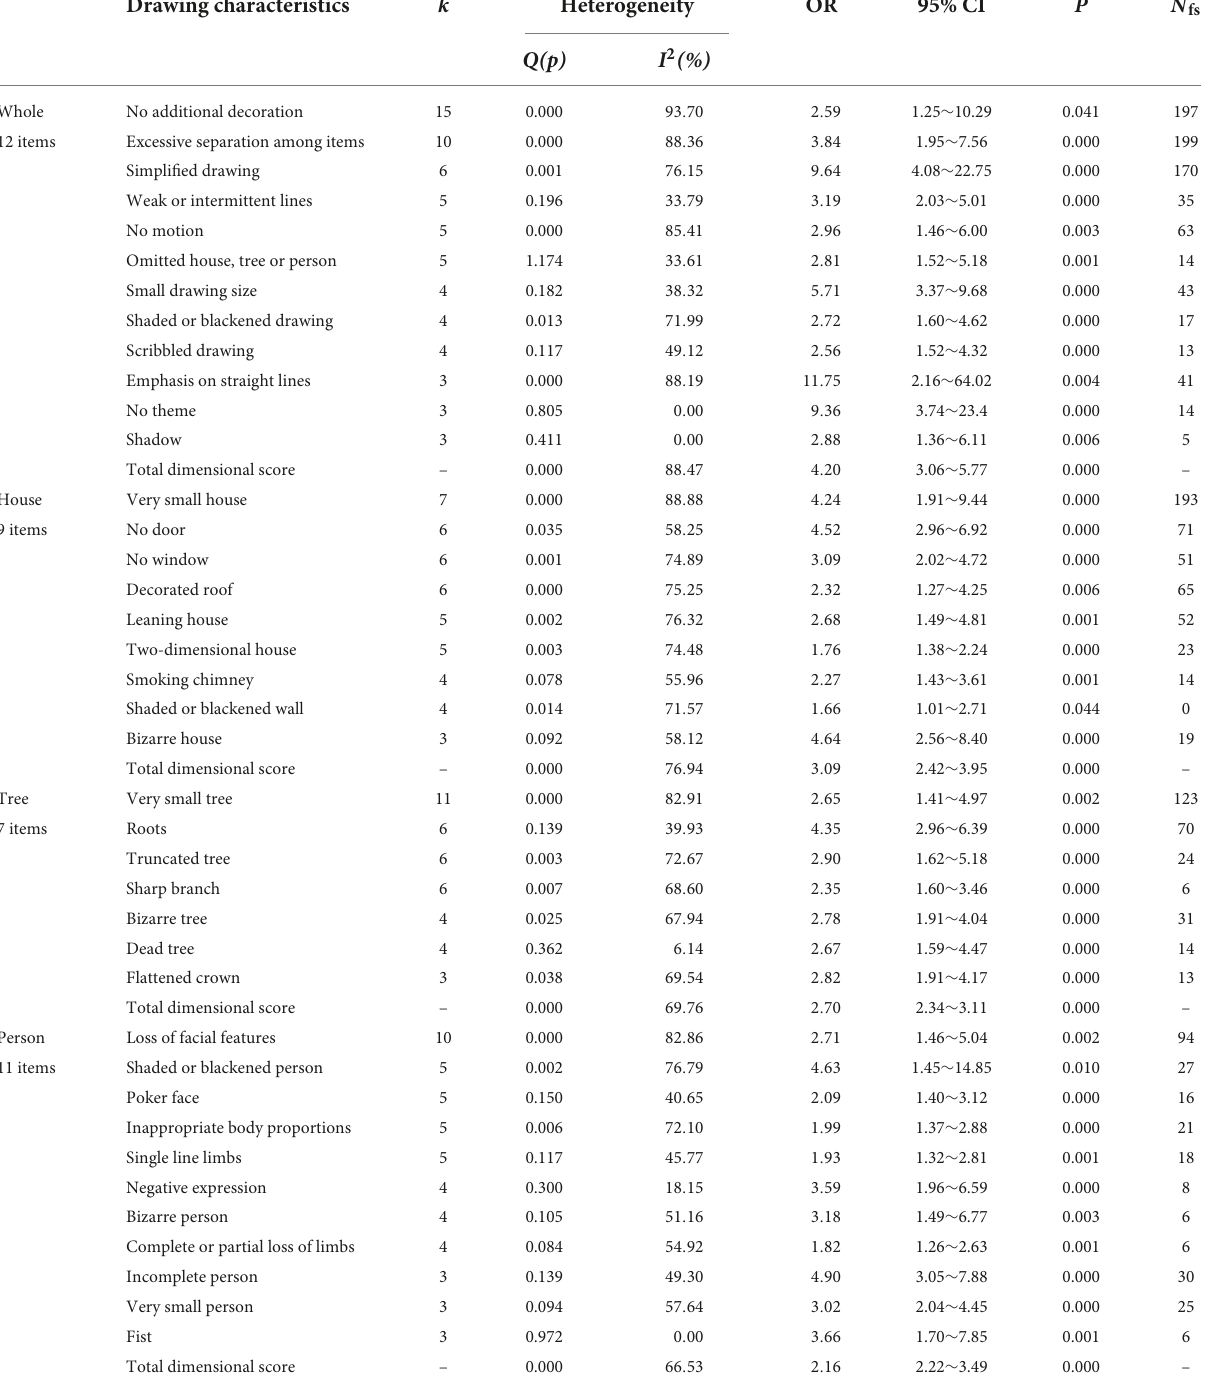
TABLE 2 The predictive effect of drawing characteristics on mental